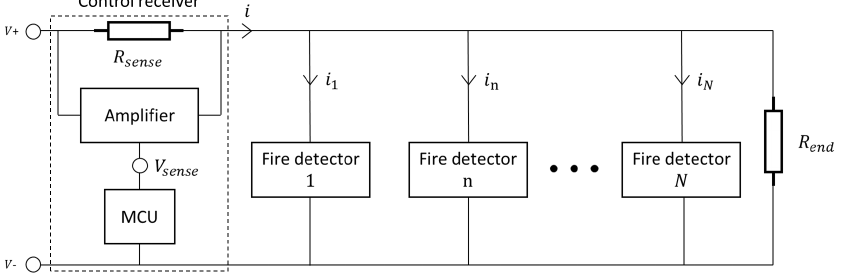
Figure 1. System